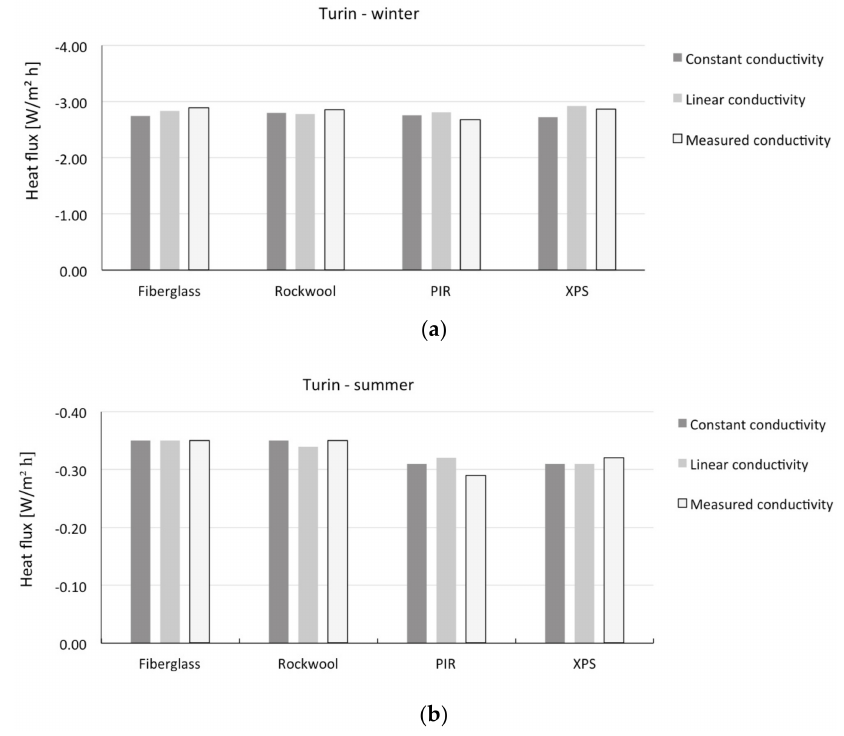
Figure 6. Heat flux average in exterior walls in Turin. ( a ) Turin—winter; ( b )